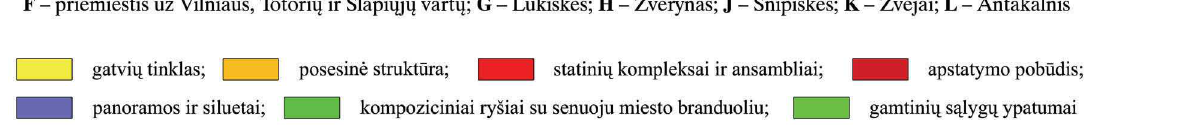
Fig 3 . Valuable components of urban structure in historic suburbs (marking does not represent the weight of each